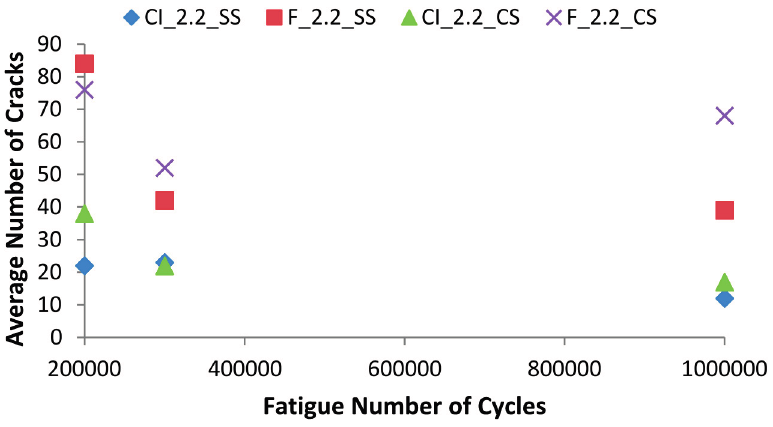
Figure 11. Average numbers of cracks at each fatigue number of cycles.